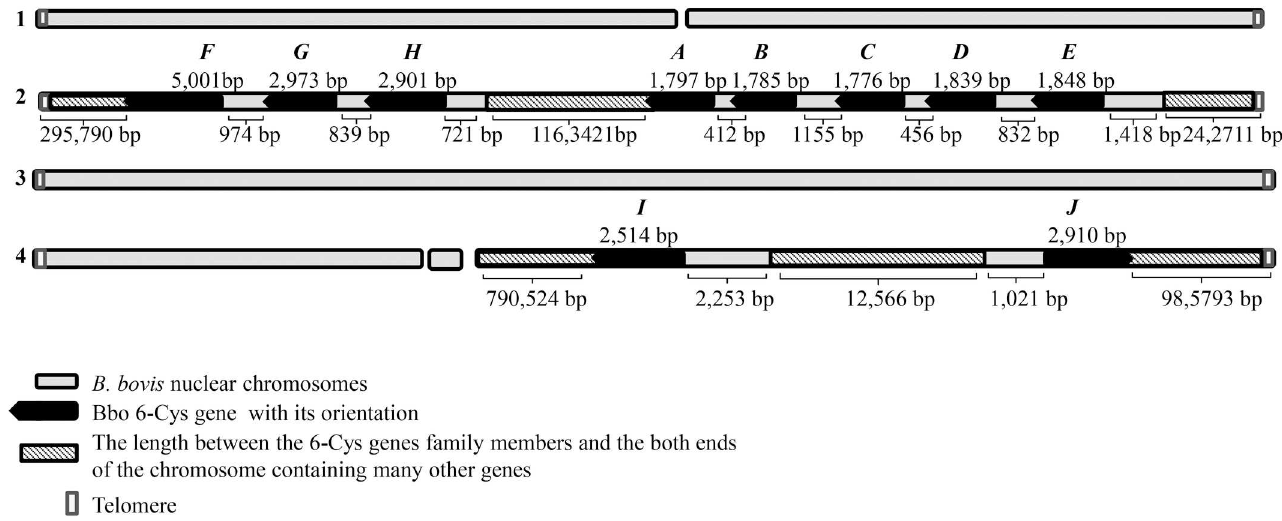
Fig 1. Bioinformatic analysis of Bbo 6-Cys family genes. Schematic representation of the locationsand relative orientationsof the Bbo 6-Cys genes family members into the four B . bovis nuclear chromosomes. The lengths of the ORFs, the intergenic regionsamong them, and their distance from the chromosomes ends are indicatedin bp. The size of the genes is not represented in a proportional scale.